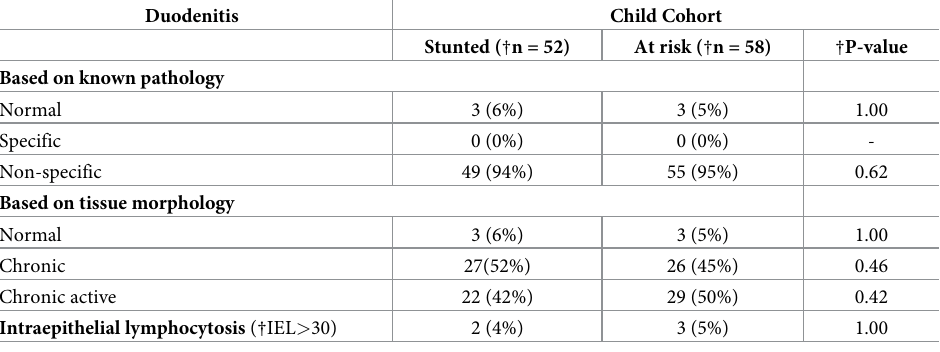
Table 1. Types of duodenitis in children.